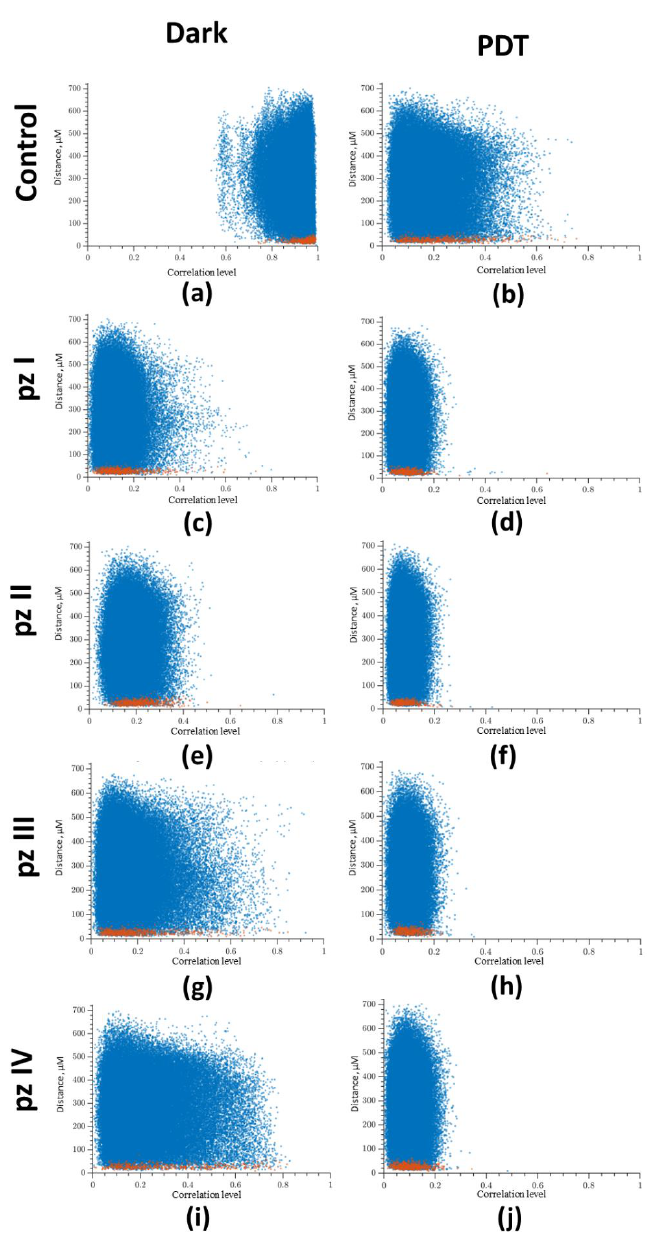
Figure 5. Dependence between the correlation level and the distance of cells pairs. The adjacent cell pairs with their soma in direct contact are highlighted in red: ( a ) control dark, ( b ) control PDT, ( c ) pz I control, ( d ) pz I PDT, ( e ) pz II control, ( f ) pz II PDT, ( g ) pz III control, ( h ) pz III PDT, ( i ) pz IV control, and ( j ) pz IV